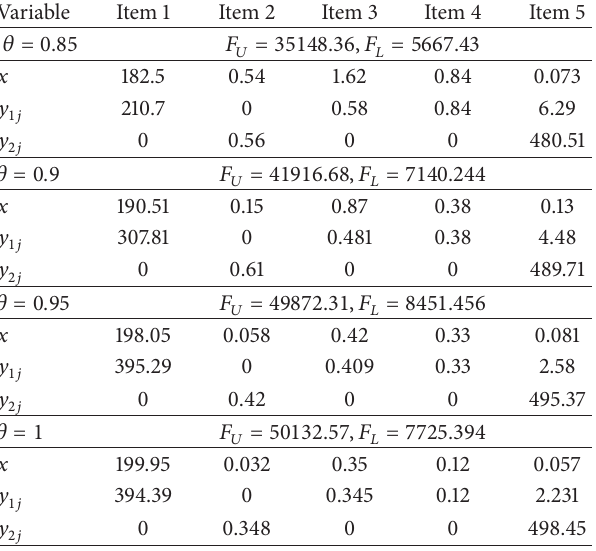
Table 3: Optimal solutions under different confidence